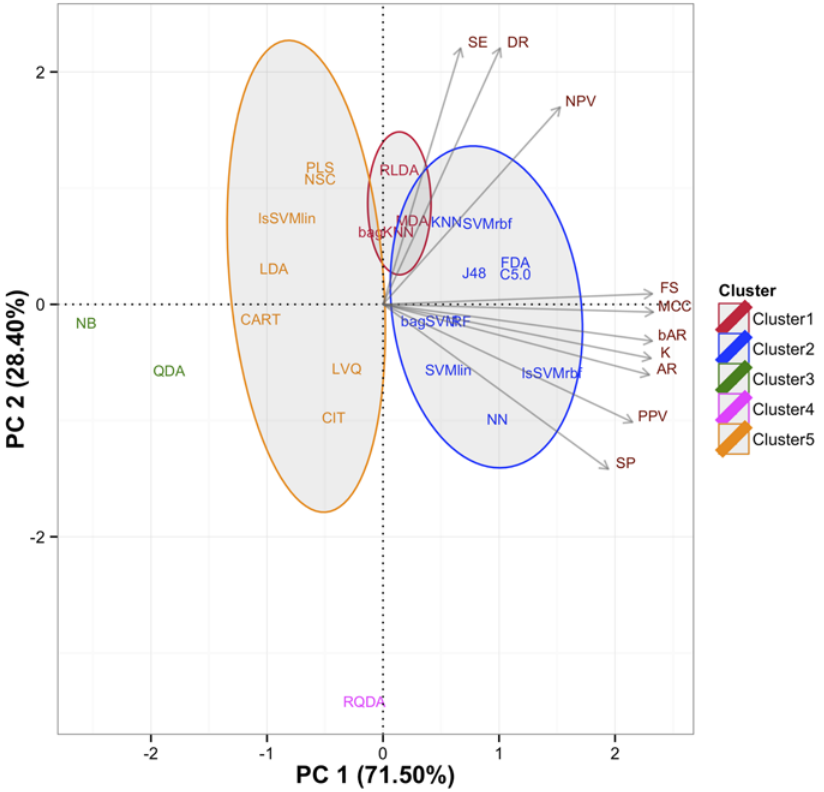
Fig 1. Principal component scores with loading biplot. Two principal components are explained almost all of the variability in the performance measures set. The first principal component accounted for 71.50% while the second principal component accounted for 28.40% of the variance of the performance measures data. Seven variables are loaded on the first principal component (AR: Accuracy rate, SP: Specificity, PPV: Positive predictive value, bAR: Balanced accuracy rate, FS: F score, MCC: Matthews correlation coefficient, κ : Kappa) whereas three variables (SE: Sensitivity, NPV: Negative predictive value, DR: Detection rate) are loaded on the second principal